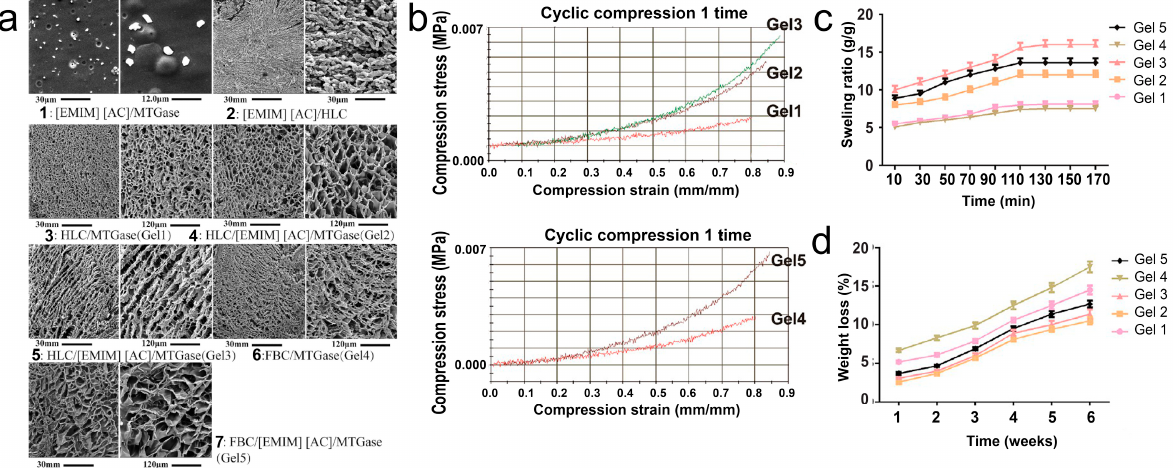
Figure 15. Comparative of three hydrogels of HLC and FBC at different incorporations of ILs. 0, 2, and 4 of mL IL g HLC − 1 for gel 1, 2, and 3 respectively, and 0 and 2 mL IL g FBC − 1 for gels 4 and 5 respectively. ( a ) SEM images of cross-sections of MTGase/[Emim][Ac] (1), HLC/[Emim][Ac] (2), Gel1 (3), Gel2 (4), Gel3 (5), Gel4 (6), and Gel5 (7). ( b ) Compression stress and compression strain of wet gels. ( c ) Swelling behavior in PBS solution ( d ). Degradation of hydrogels measured as the percentage weight loss in 6 weeks. Reproduced with permission of the American Chemical Society [141].